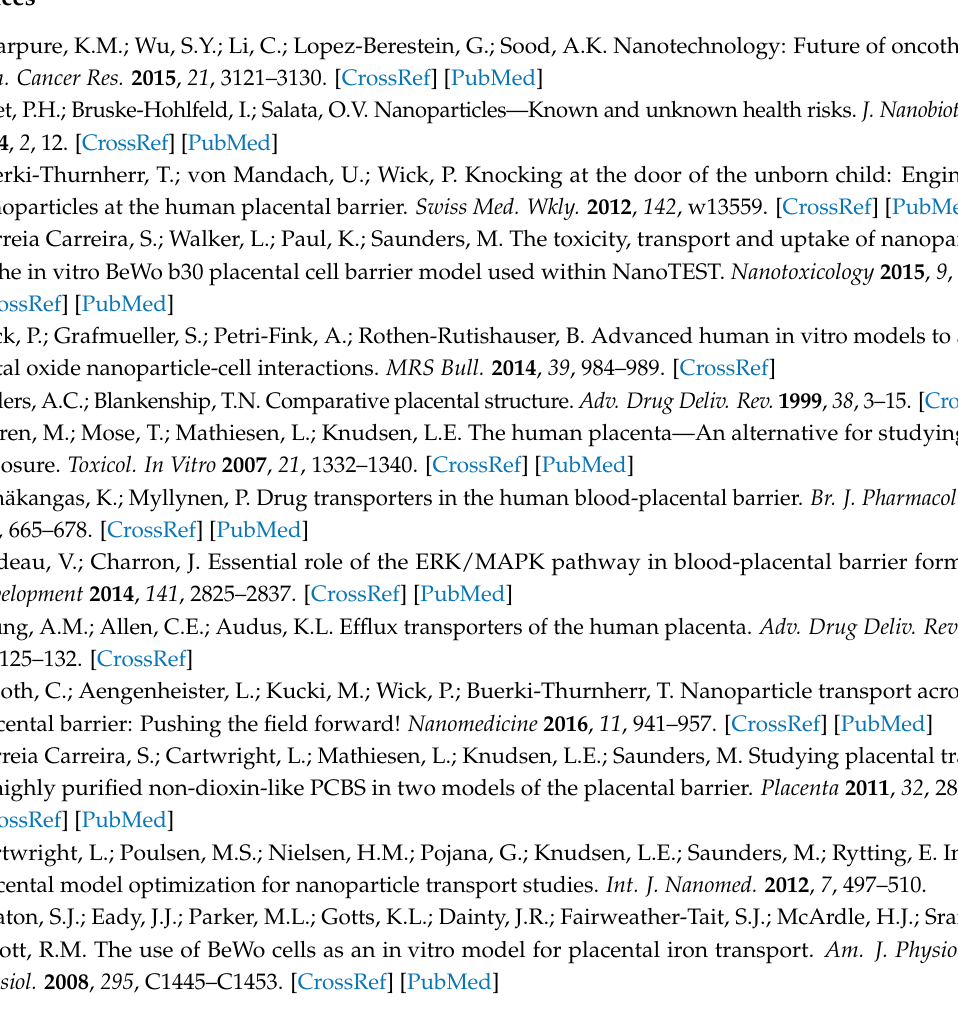
Figure S1: Schema for the timeline of preparation of the blood-placenta barrier model Figure S2: Comparison of expression of cell-cell contact markers β -catenin and ZO-1 for mono- and co-culture models, Figure S3: Cellular viability of BeWo cells and pericytes after short-term incubation with SPIONs. Table S1: Detailed characterization and properties of SPIONs, Table S2: Statistical analysis of data shown in Figure 2c, Table S3: Statistical analysis of data shown in Figure 2d, Table S4: Statistical analysis of data shown in Figure 3a, Table S5: Statistical analysis of data shown in Figure